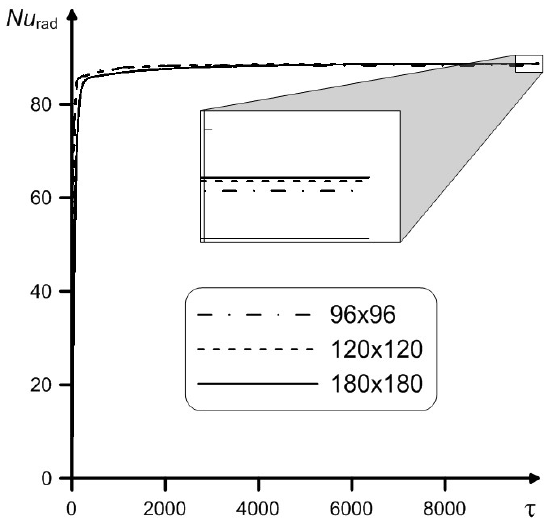
Figure 4. Dependences of the average radiative Nusselt number at left wall vs. various grids and dimensionless time.